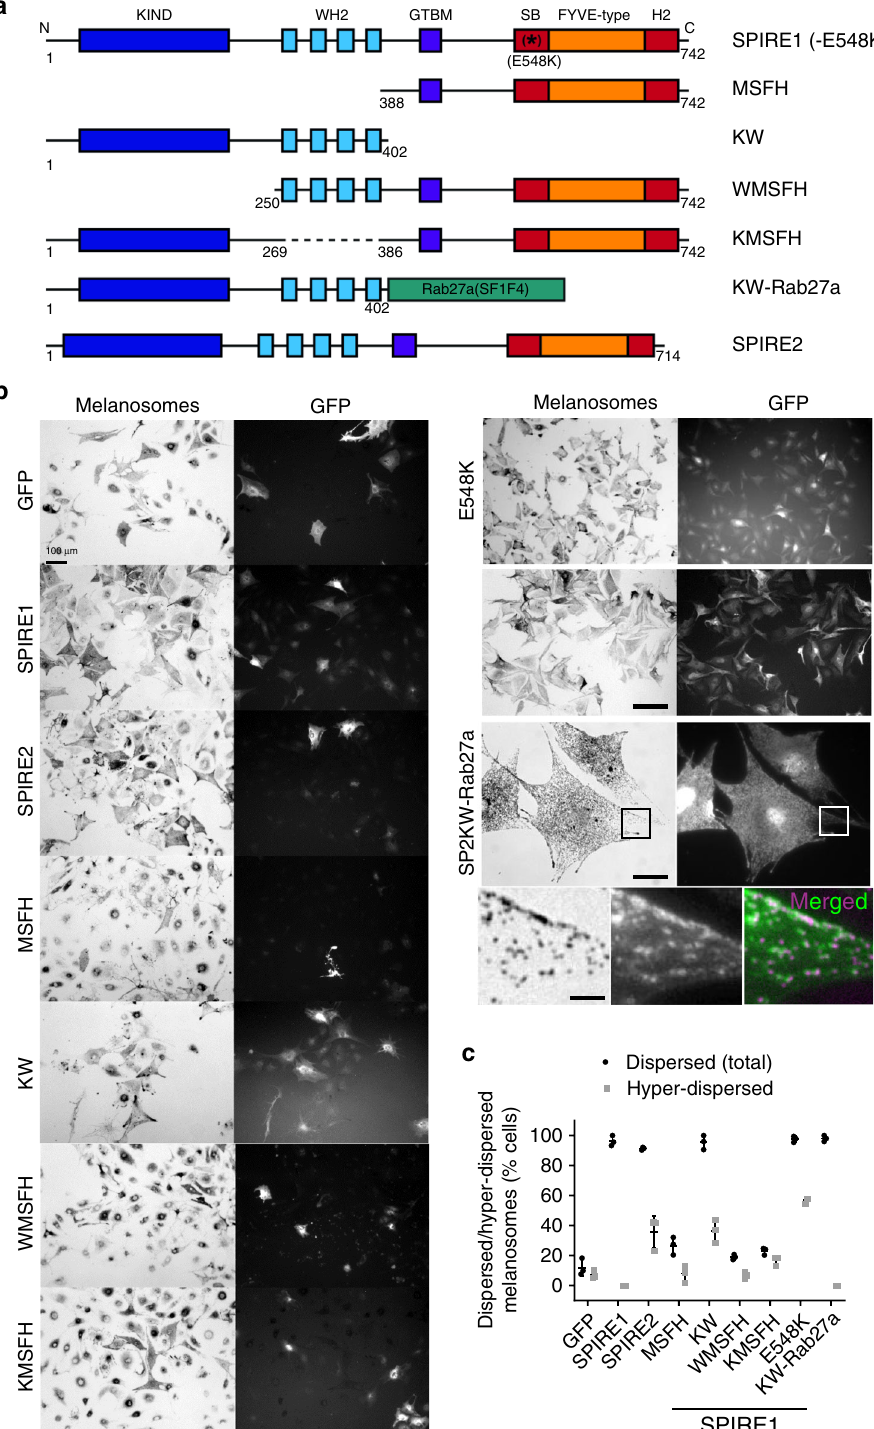
Fig. 4 The FMN interaction (KIND) and AF nucleation (WH2) domains of SPIRE1 are essential for melanosome dispersion. a A schematic representation of the domain structure of human SPIRE1, and the correspondence with mutant and chimeric proteins used in functional studies ( b , c ). Numbers indicate amino acid boundaries. K KIND, W WH2, M GTBM globular tail domain binding motif, S SB SPIRE box, F FYVE-type zinc fi nger, H C- terminal fl anking sequences similar to H2 of Slp/Slac-proteins. b melan-a cells were depleted of SPIRE1/2 by siRNA transfection and 72 h later infected with adenoviruses expressing the indicated proteins. Cells were fi xed 24 h later, processed for immuno fl uorescence and imaged using bright- fi eld and fl uorescence optics to observe melanosome and protein distribution/expression (see Experimental procedures). Scale bars = 100, 20 and 3 μ m in low, medium and high-magni fi cation images. Boxes in KW-Rab27a images indicate the region shown below. For the merged image green = KW-Rab27a and magenta = melanosomes. c Is a bee swarm plot showing the percentage of human SPIRE1/2 expressing SPIRE1/2-depleted melan-a cells (50 cells for each condition in each experiment), in which melanosomes are classed as dispersed and/or hyper-dispersed. Results shown are from of three independent experiments. Source data for c are provided in the Supplementary Source data fi